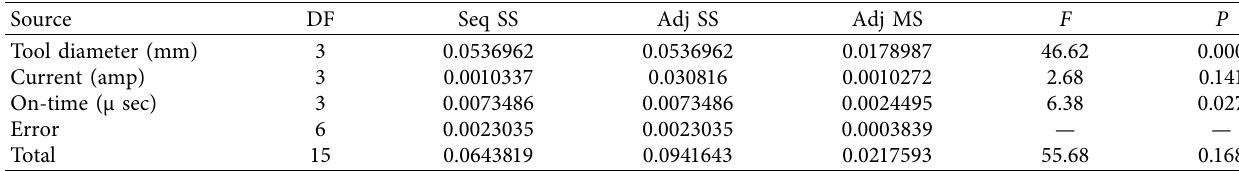
Table 5: Analysis of variance for MRR, using adjusted SS for tests.